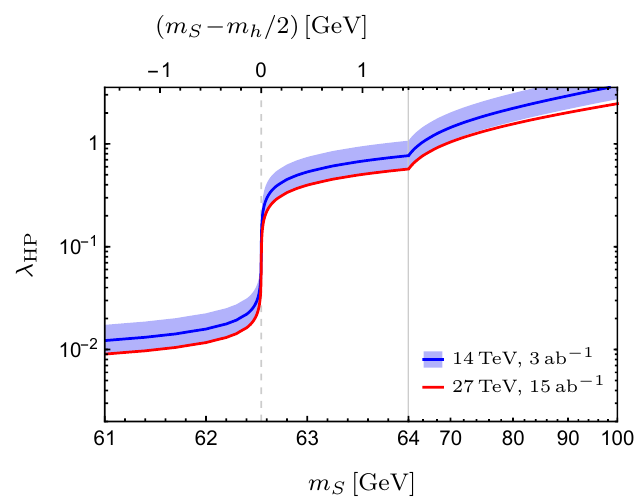
Figure 4 . Projected 95 % CL upper limits on the Higgs-portal coupling for the 14 TeV HL-LHC (blue curve) and 27 TeV HE-LHC (red curve) assuming an integrated luminosity of 3 ab (cid:0) 1 and 15 ab (cid:0) 1 , respectively. The shaded band around the blue curve indicates the sensitivity of the respective limit to the systematic error on the background from ref. [42] which is multiplied by a factor of 2 (1/2) for the upper (lower) boundary of the band. To resolve the resonant region, for the abscissa we impose a scale break at a DM mass of 64 GeV, below (above) which we plot the mass linearly